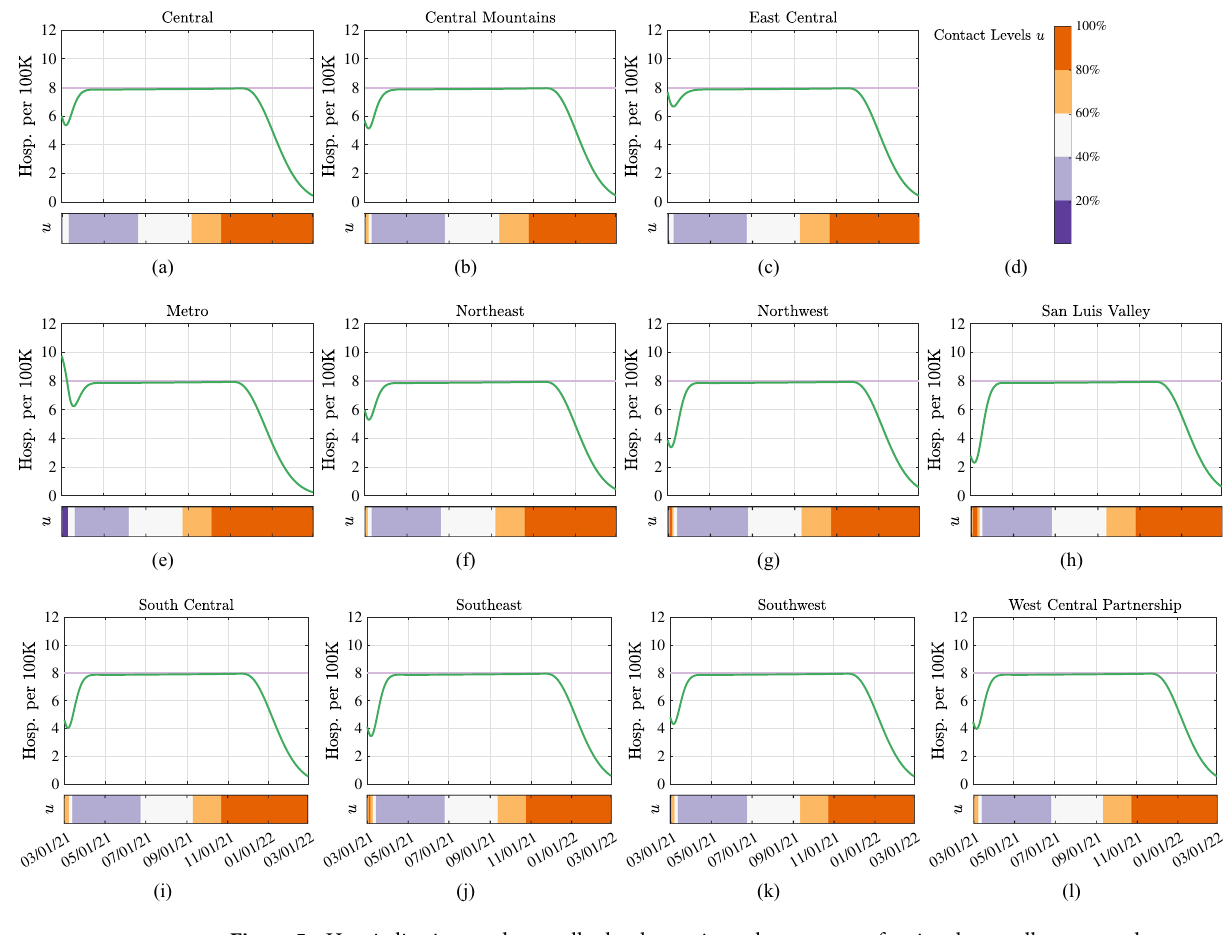
Figure 5. Hospitalizations and controller level over time when a group of regional controllers are used to guarantee that pre-specified region-dependent hospitalization limits are not violated. Each of the 11 panels shows the evolution in a different LPHA region (see Fig. 4 for an illustration of the connectivity graph). Simulation are conducted with a state-wide vaccination rate of 20,000 vax/day, to a maximum vaccine update of 70%. Solid green lines illustrate the evolution of the hospitalized state, light purple lines show the pre-specified hospitalization limit. Heat maps illustrate the required level of NPIs u i , as determined by the